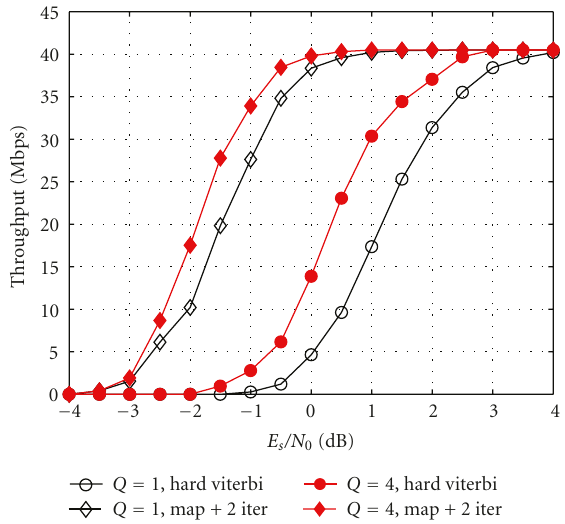
Figure 5: Configuration 3: 40MHz, SDM ( N T = 3, N s = 3, N R = 3), BPSK modulation. Throughput with (solid markers) and without (hollow markers)